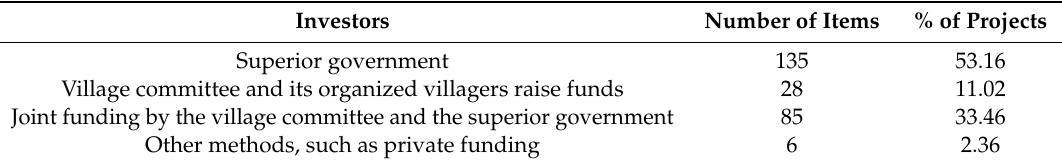
Table 3. Agricultural infrastructure funding.